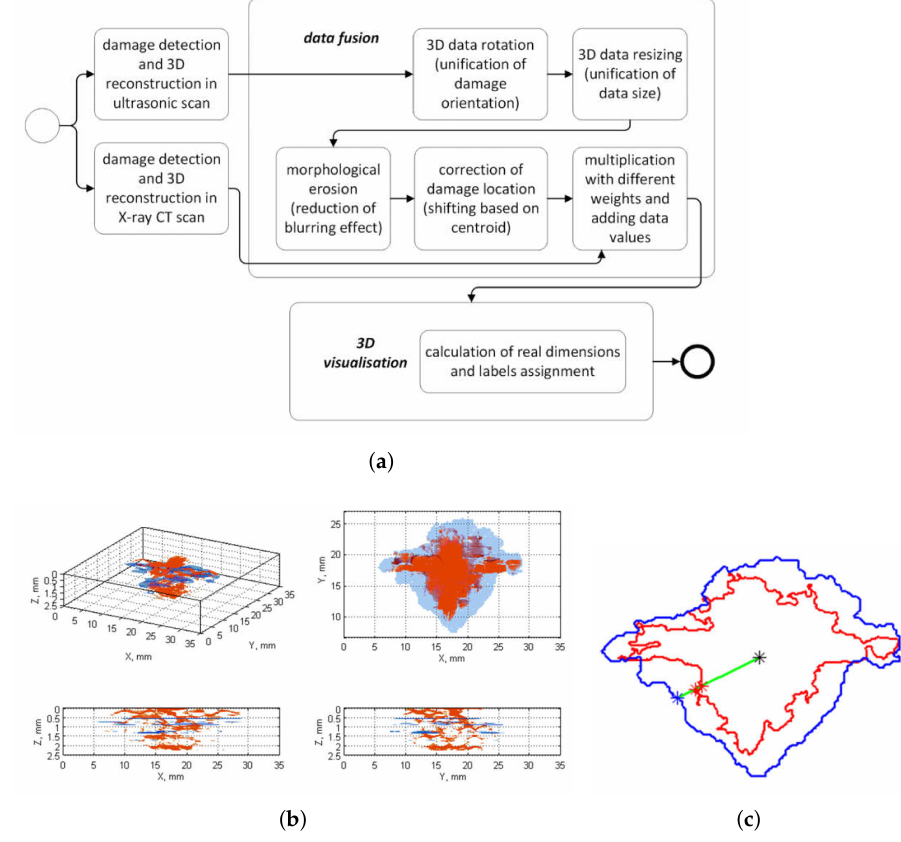
Figure 9. ( a ) Katunin-et-al. example fusion approach (block diagram). ( b ) Detected damage for fusion of X-ray CT scan (red) and UT C-Scan (blue color). ( c ) Distance calculation of boundary points to the centroid for X-ray CT and UT C-scan